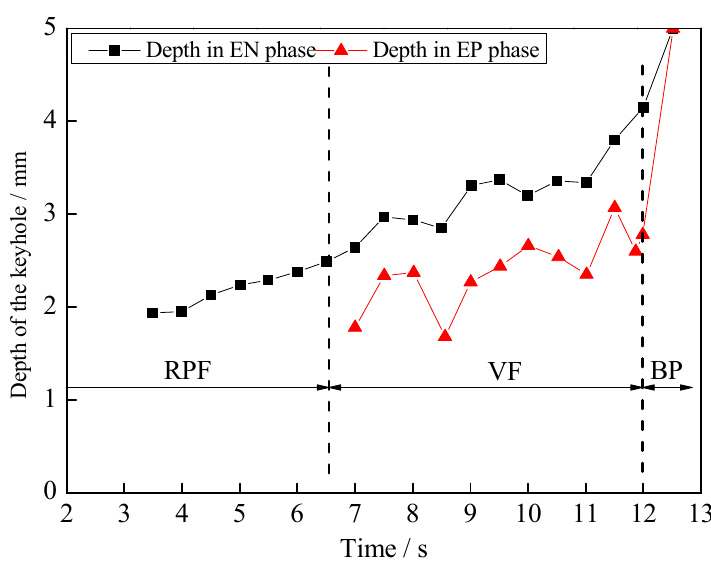
Figure 9. The keyhole boundary indicated by image edge extraction.